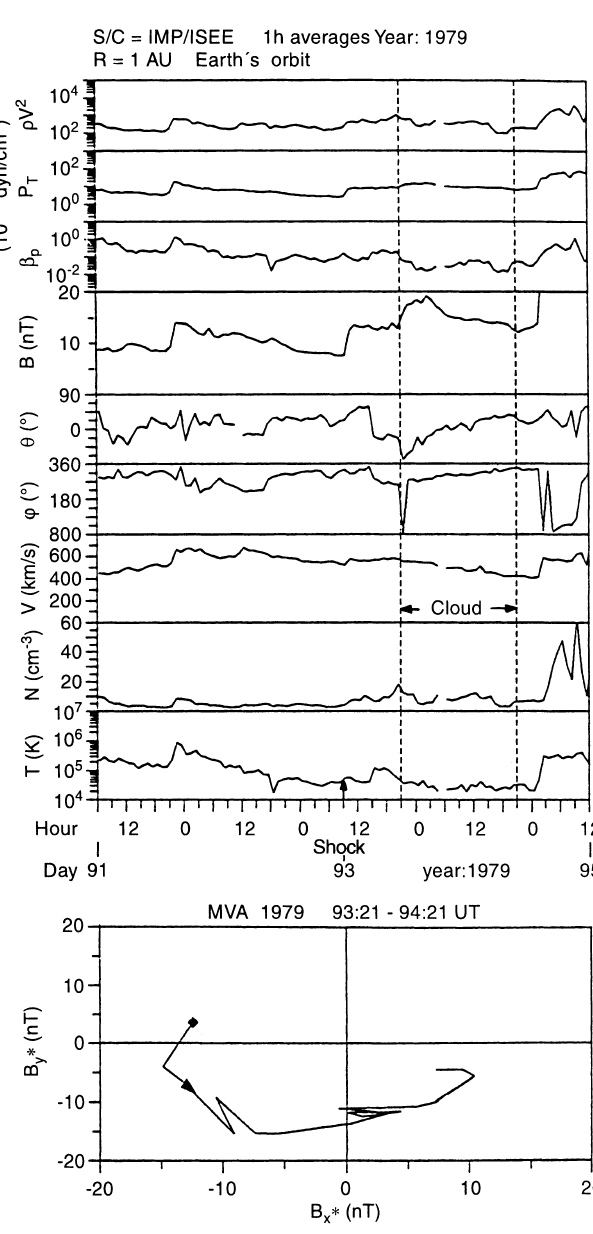
Fig. 10. Solar wind parameters of a MC ( dashed lines ) that passed Helios 2 at 0.7 AU, 27 (cid:14) E of Earth on day 93, 02–18 UT ( left panel ) and Earth’s orbit on days 93, 21 UT – 94, 21 UT ( right panel ). Times